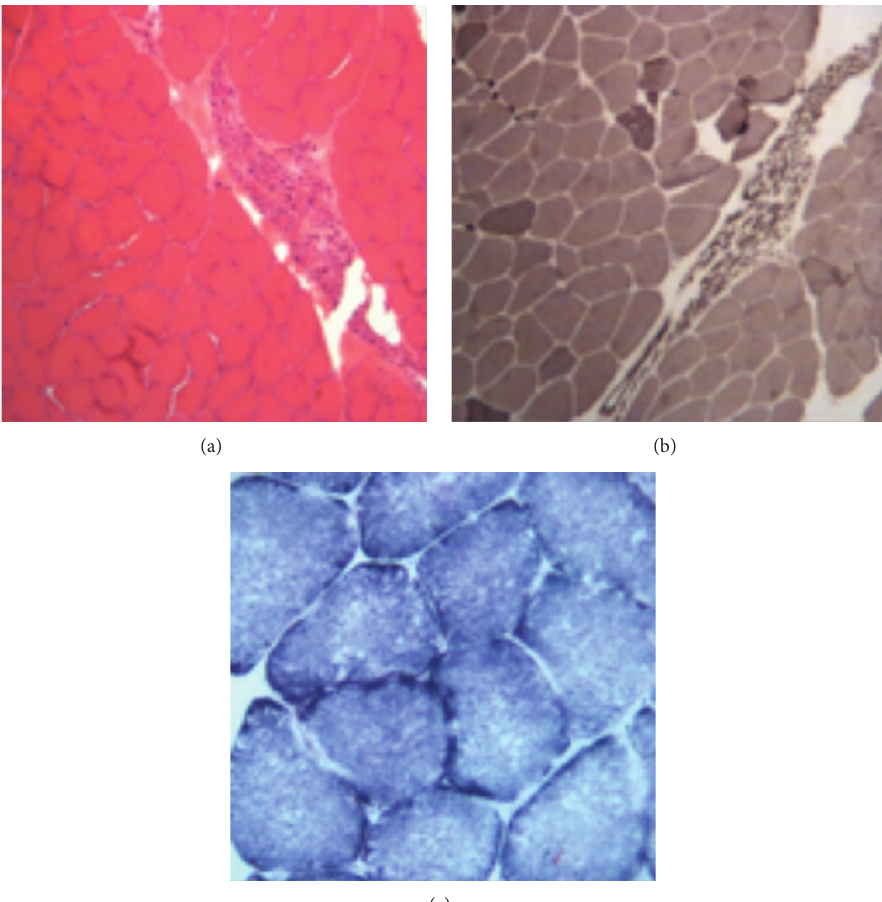
Figure 2: Histopathologic finding on muscle biopsy. (a) H&E: large group atrophy (atrophic muscle, an issue surrounded by other normal appearances of fascicles or scattered angular atrophic fibers). (b) ATPase reaction aspects of type-grouping, typical neurogenic muscular atrophy; muscular fascicle and the atrophic consisting of a single type of fiber; in this case type I and the other parts are nearly all composed of fibers of type II. (c) Oxidative reaction SDH aggregates subsarcolemmal hyperchromatic, crescent-shaped, which correspond to the accumulation of